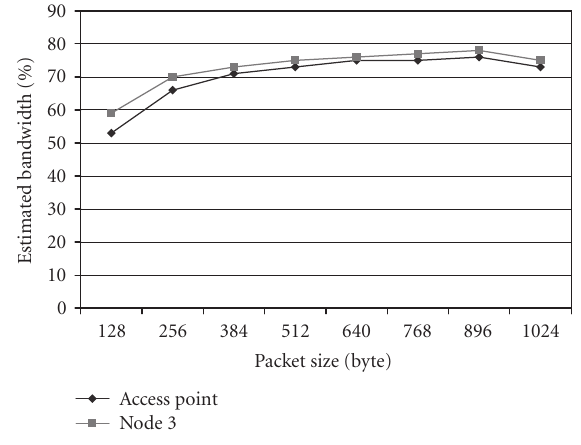
Figure 7: Estimated bandwidth with di ff erent packet